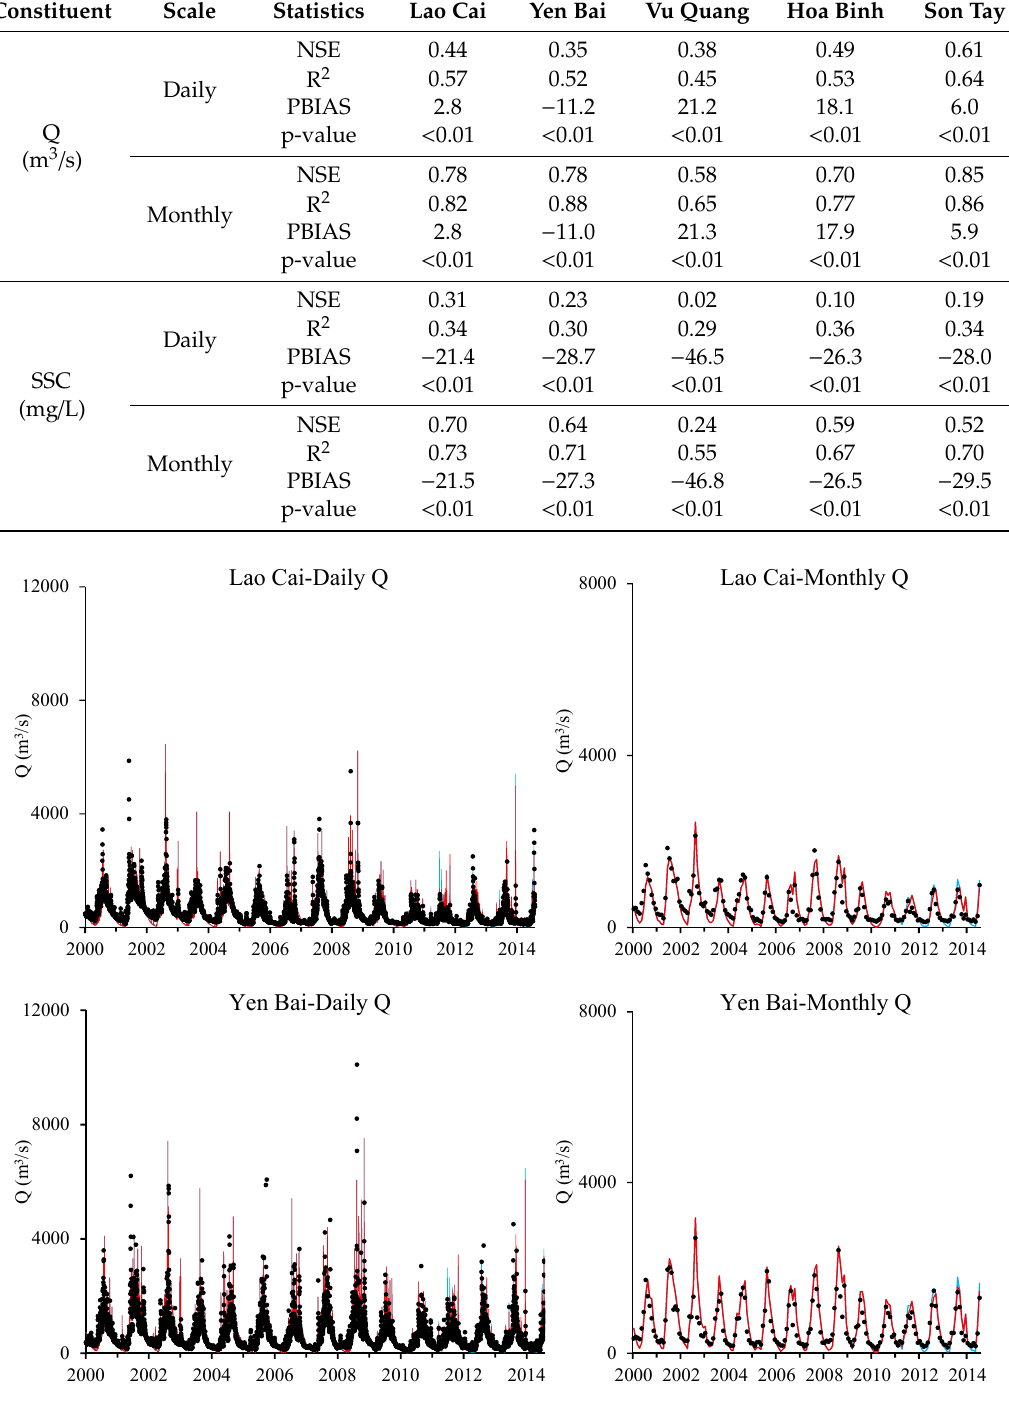
Table 5. Evaluation Statistics of Observed and Simulated Discharge (Q), Suspended Sediment Concentration (SSC) and Sediment Flux (SF) on Di ff erent Time Scales for Each Station.